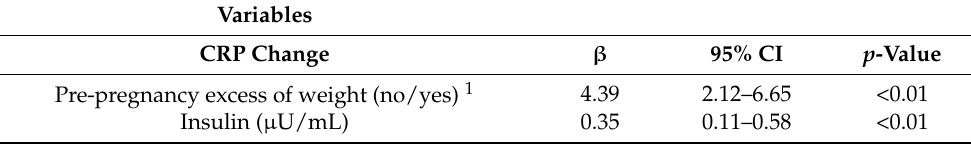
Table 3. Adjusted longitudinal linear regression modelfor excess weight (yes/no) based on pre-pregnancy BMI and CRP levels from pregnancy to postpartum among pregnant women with